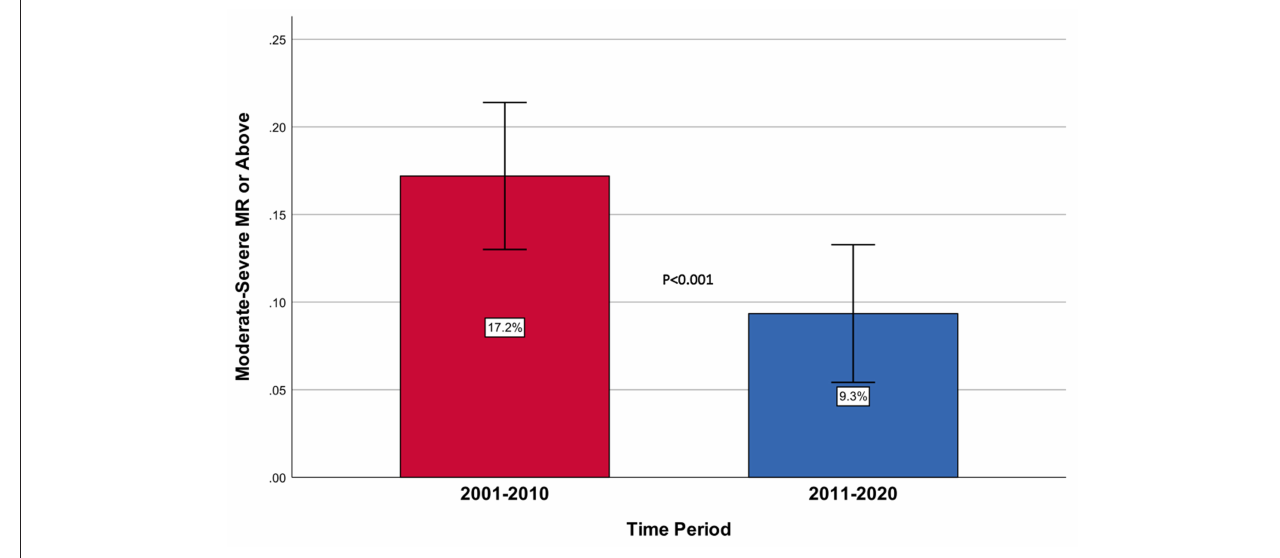
FIGURE 3 | Rates of moderate-severe or above IMR by period.